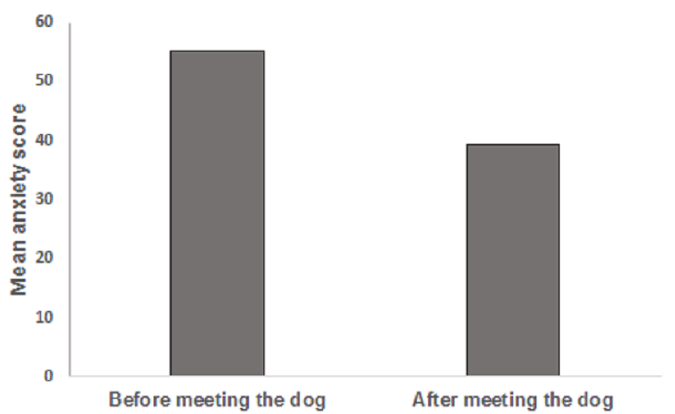
Figure 3. Survivors’ anxiety about their upcoming police interview, before and after engaging with the facility dog. Higher scores indicate greater anxiety.